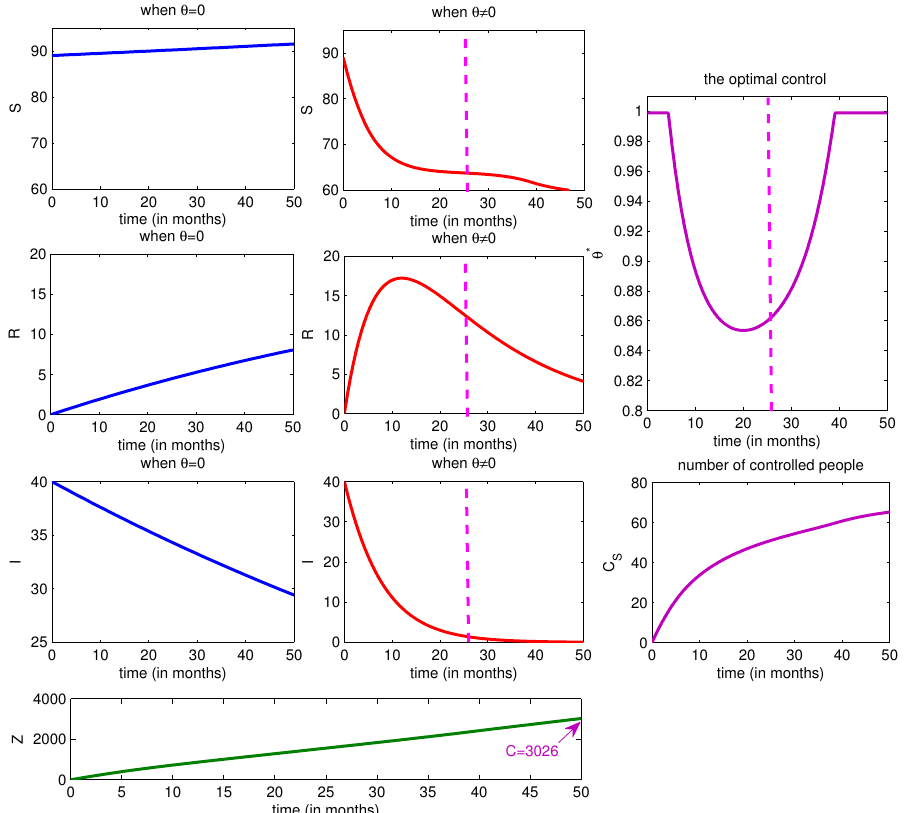
Figure 1. SC S IRZ dynamics in the absence and presence of the control in the two cases θ = 0 and θ (cid:54) = 0. Parameters values: Π = 6.45, a = 0.06, b = 0.001, β = 0.0003, and µ = 0.05, γ = 0.1. Initial conditions: S ( 0 ) = 89, C S ( 0 ) = 0, I ( 0 ) = 40, and R ( 0 ) = 0. Severity weights constants: a (cid:48) = 1 and b (cid:48) =